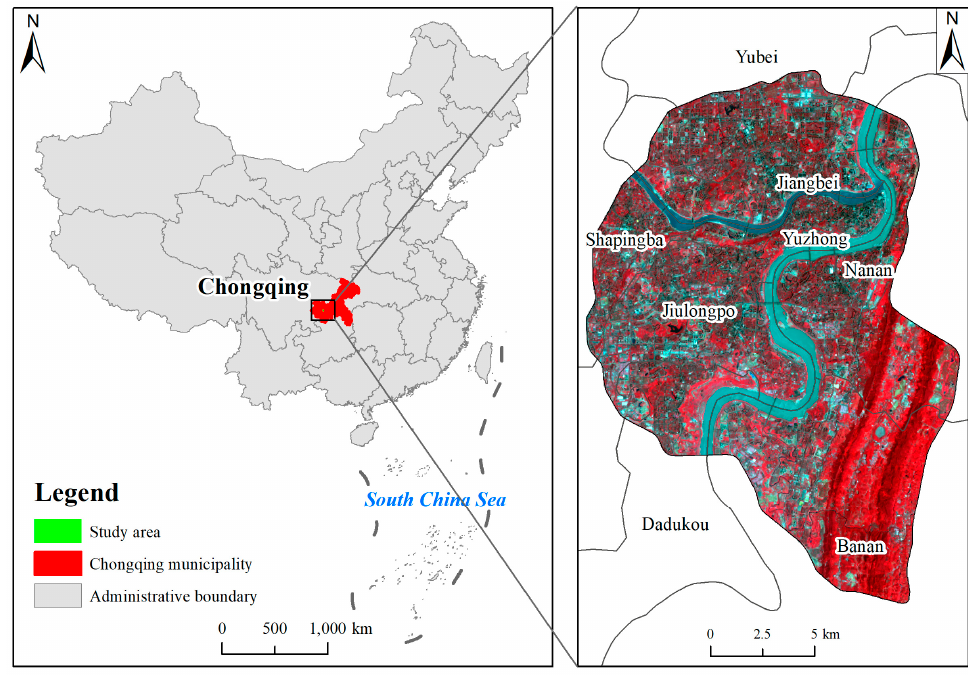
Figure 1. Location of the study area.